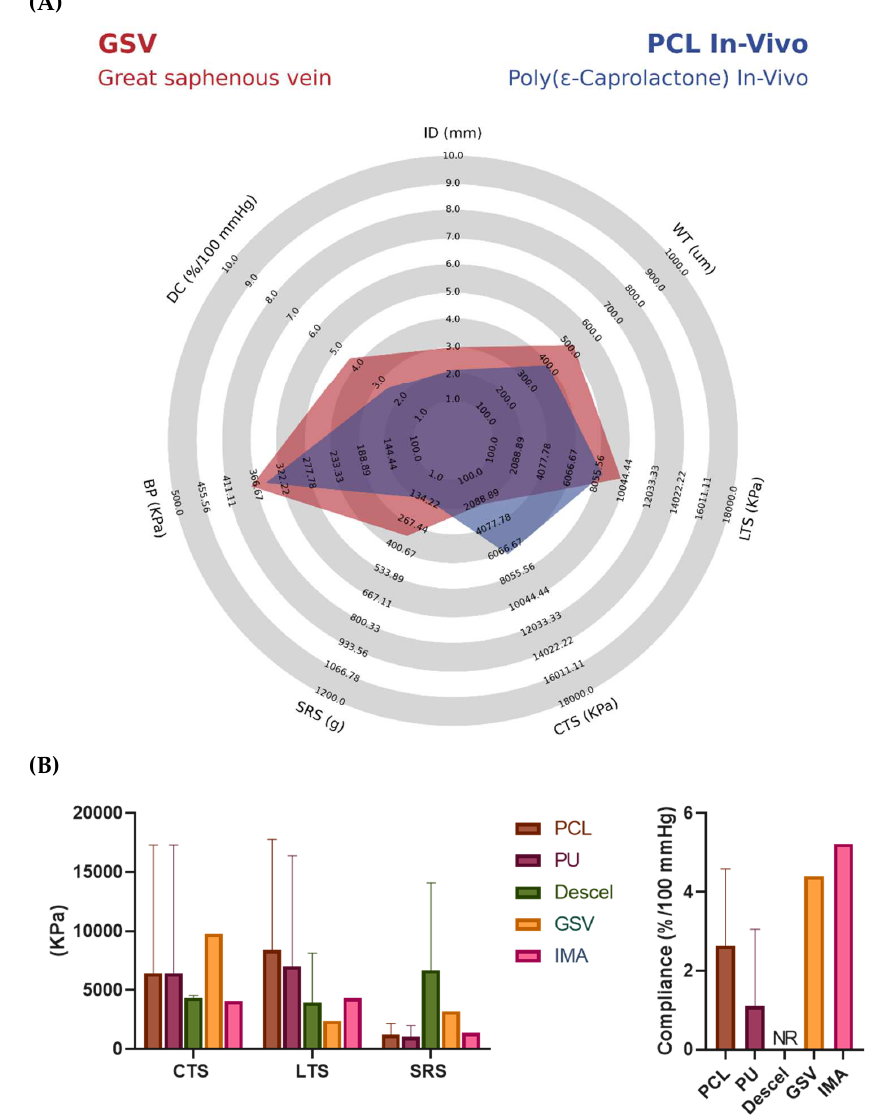
Figure 7. ( A ) Mechanical properties comparison of great saphenous vein, as a gold standard, and Poly( ε -Caprolactone) tested in vivo. Mechanical properties identified include internal diameter (ID), wall thickness (WT), longitudinal tensile strength (LTS), circumferential tensile strength (CTS), suture retention strength (SRS), burst pressure (BP), and dynamic compliance (DC). Chart generated from the Python library developed by StatsBomb/Anmol Durgapal (accessed on 29 May 2022). ( B ) Mechanical properties comparison of great saphenous vein, as a gold standard, internal mammary artery and each graft made in clinical trials. Circumferential tensile strength (CTS), longitudinal tensile strength (LTS), suture retention strength (SRS), Decellularized (Descel), internal mammary artery (IMA), and great saphenous vein (GSV). Data are shown as mean ± standard deviation, according to the number of studies reporting the data. Additional information regarding descriptive analysis can be found on Table S2. Graph generated with GraphPad Prism (accessed on 29 May 2022).